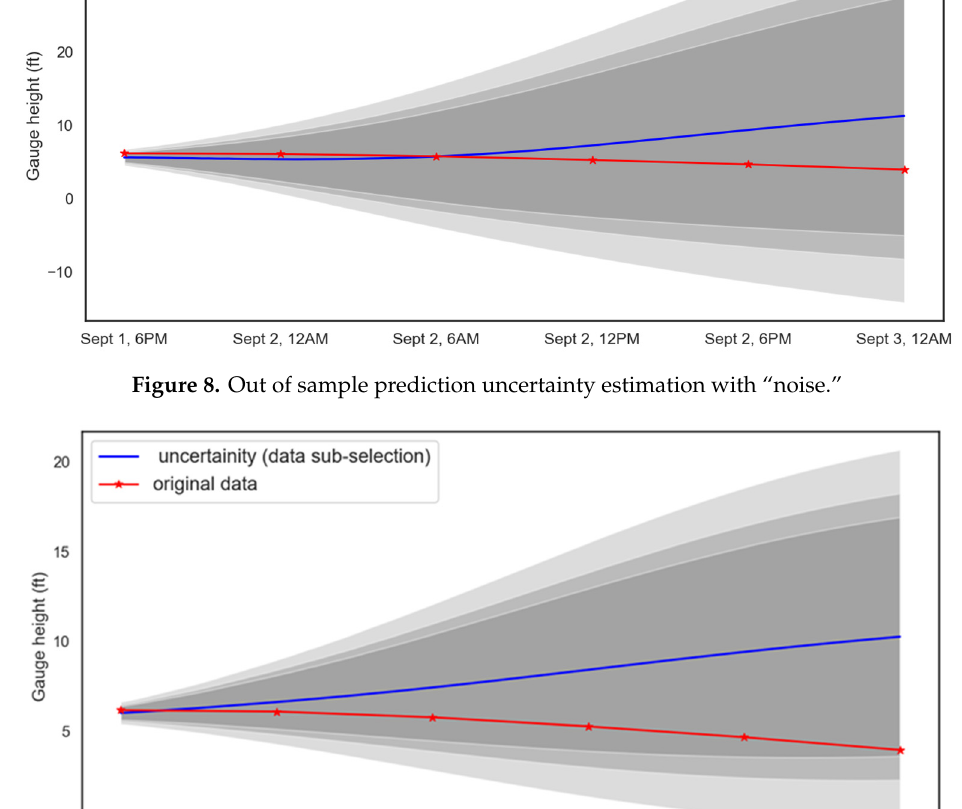
Figure 9. Out of sample prediction uncertainty estimation with “data sub-selection.” Table 6. Comparison of uncertainty estimation techniques.